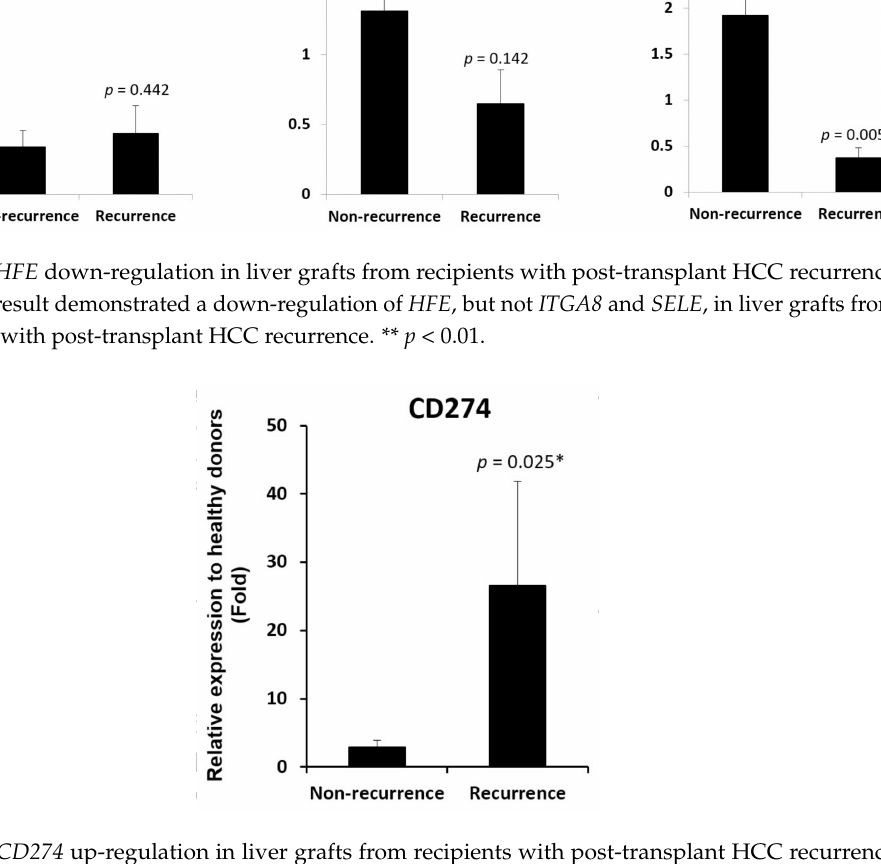
Figure 4. CD274 up-regulation in liver grafts from recipients with post-transplant HCC recurrence. RT-qPCR result demonstrated an up-regulation of CD274 in liver grafts from recipients with post-transplant HCC recurrence. * p <